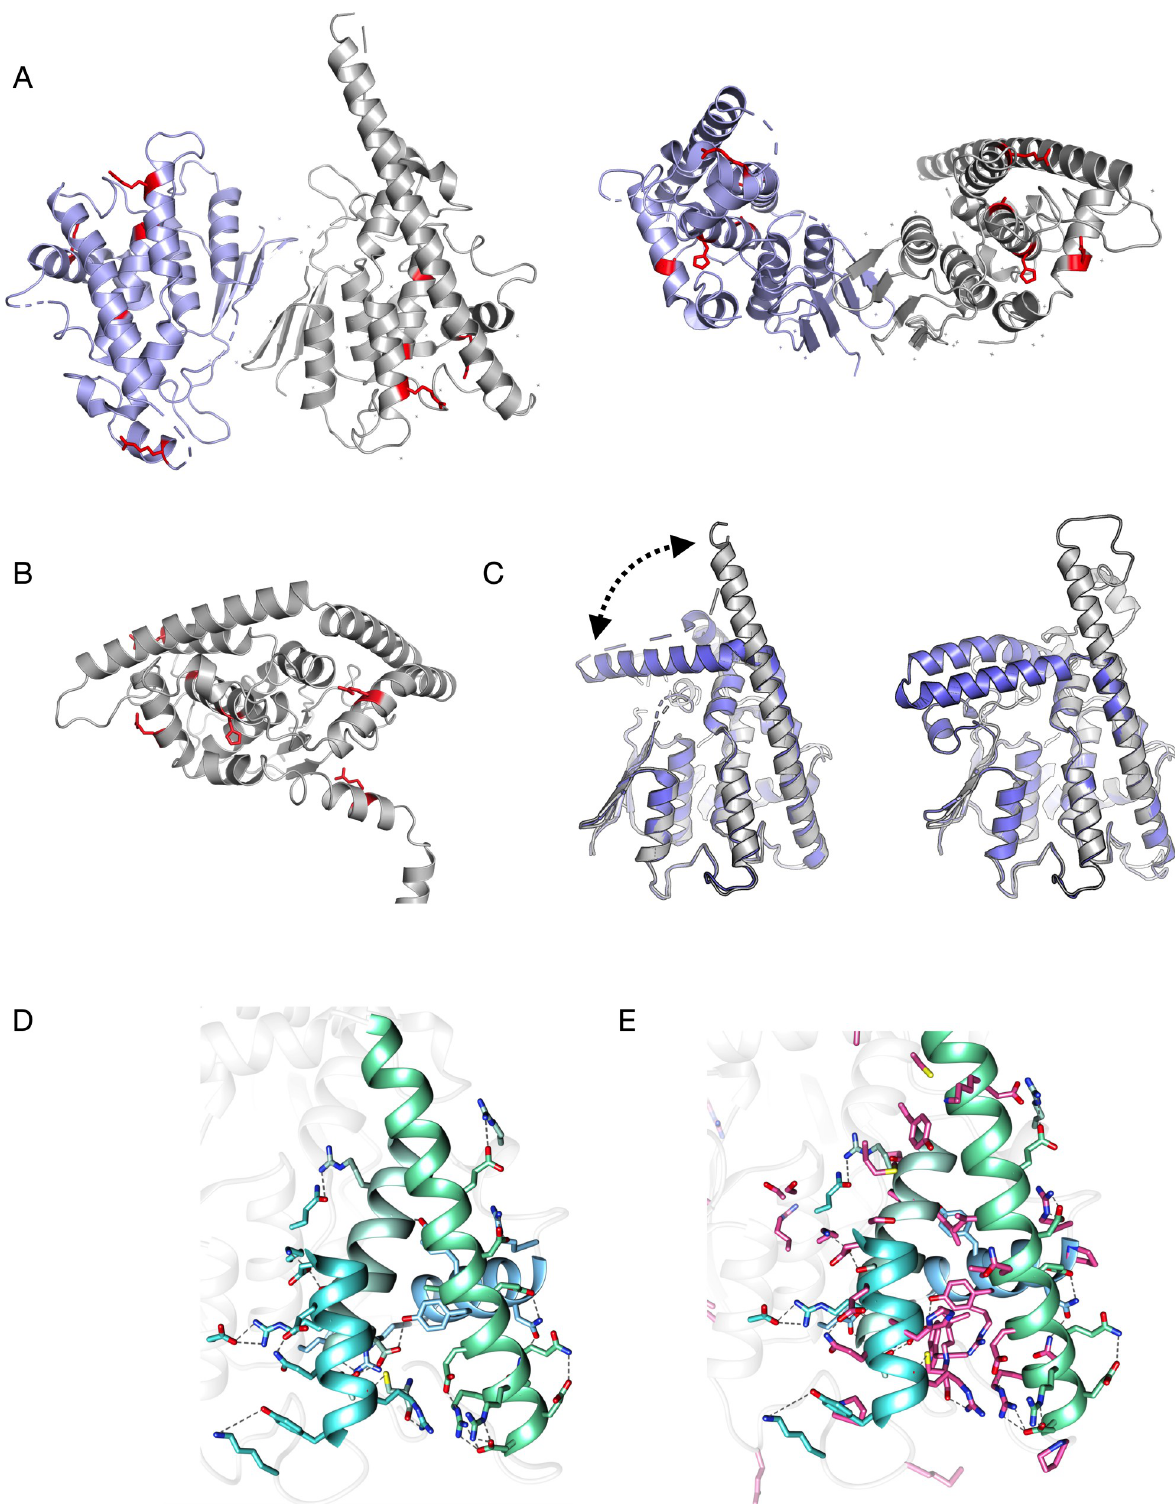
Fig 1. Overall structure of GDAP1. A. Location of the mutations studied here, mapped onto the crystal structure of wild-type GDAP1 [11] in two different orientations. At the centre of the dimer interface, a disulphide bridge between Cys88 from each protomer links the dimer covalently. B. The mapping of the mutations studied here (red) onto the AlphaFold2 model, to include those not visible in the crystallised construct (R161H, R310Q,